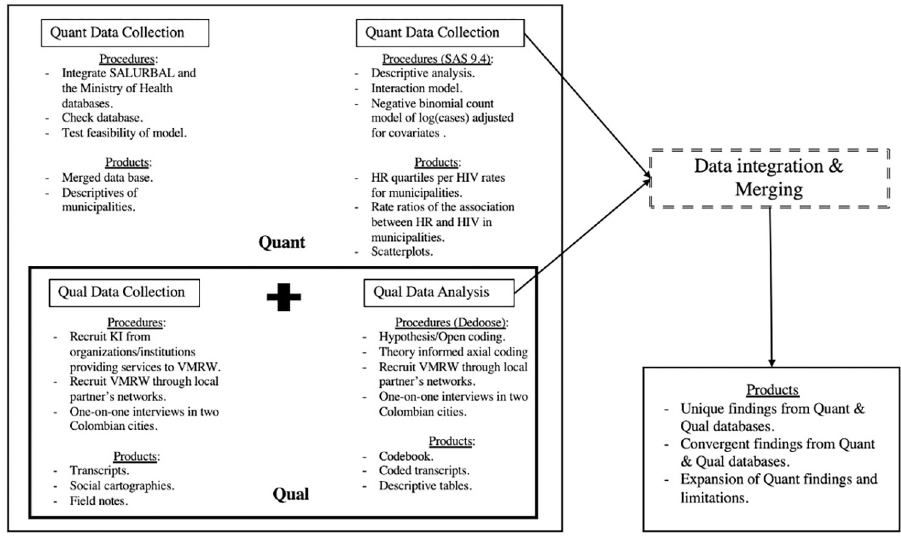
Fig 1. Schematic of concurrent (Quant + Qual) design